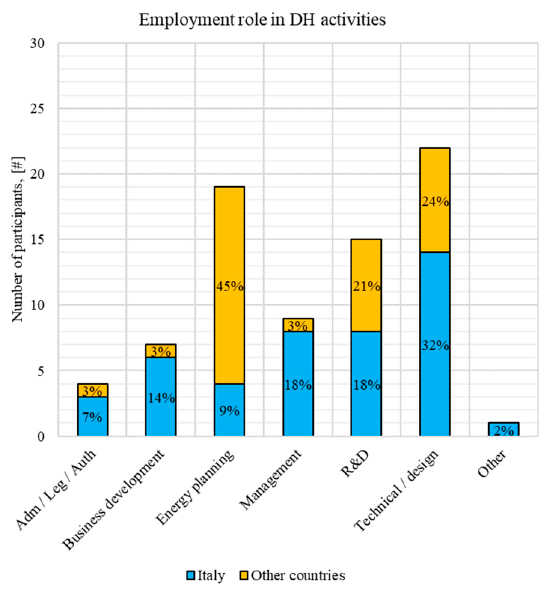
Figure 5. Number of survey participants as a function of the employment role engaged in DH activities.